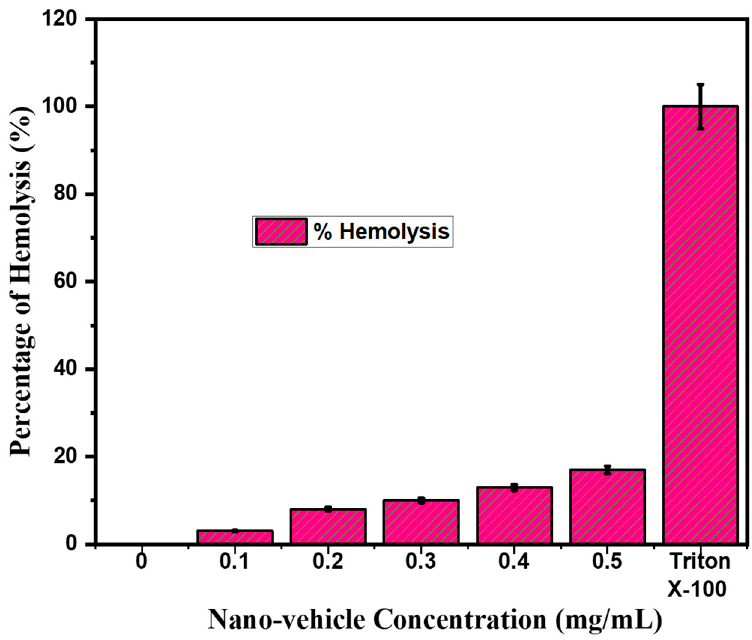
Figure 6. Hemolysis percentages of the rutin-loaded SNPs gel.